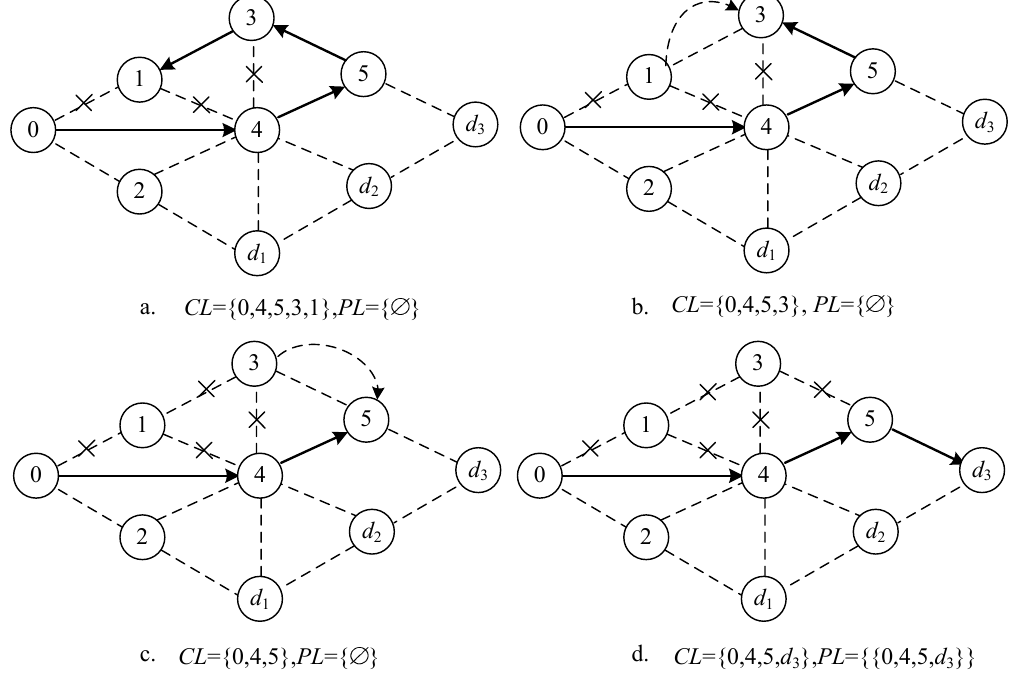
Figure 3. An instance of producing the self-loop.